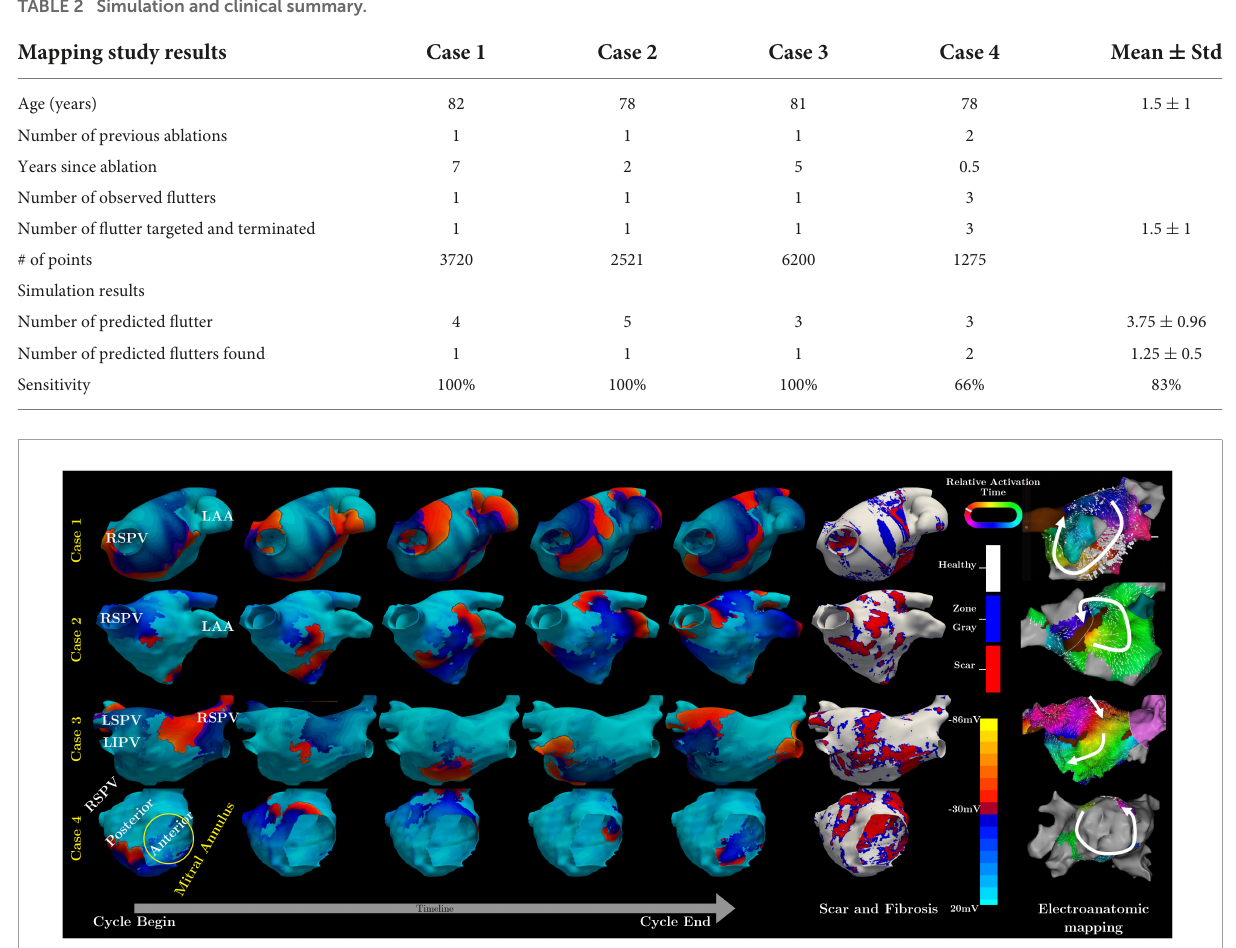
FIGURE1 Summary of simulated and measured flutter circuits in four subjects. The left-hand panel contains a sequence of five simulated maps of transmembrane potential throughout a single re-entry cycle for each of the four cases. The sixth column shows the geometric model with scar and fibrosis, as obtained from LGE-MRI. The rightmost column contains the activation maps measured from each